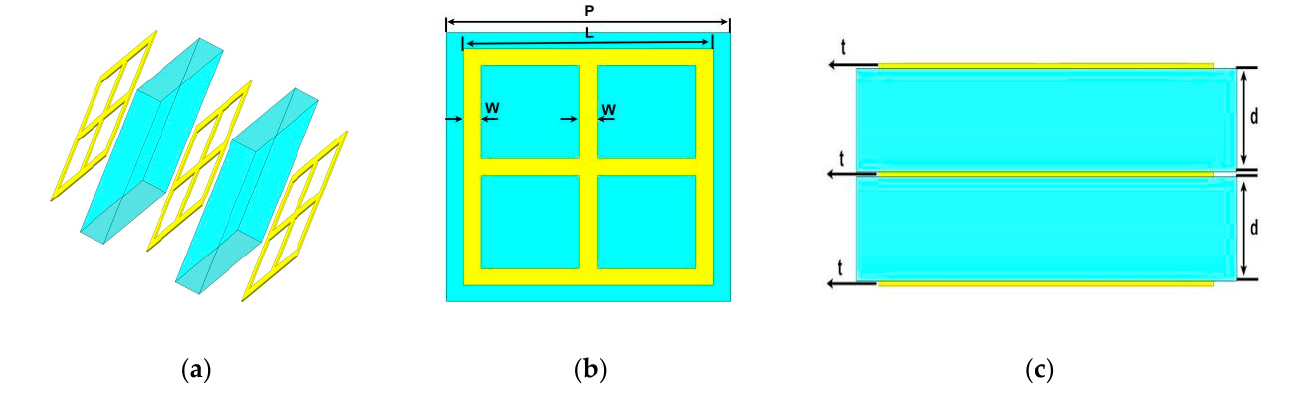
Figure 1. Structure of THz filter: ( a ) Layered structurer; ( b ) Top view; ( c ) Side view. The broadband filter designed in this paper is computer simulated and optimized using the frequency domain solver of CST Microwave Studio. In order to simulate an infinitely periodic cell, periodic boundary conditions are selected along the x-y plane during the simulation, while open boundary conditions are selected along the z plane during the simulation. In addition, the electric (E) and magnetic (H) fields are parallel to the incident plane, while the propagating wave vector (k) is perpendicular to the structure plane. To explore the filtering performance of this filter, the transmission coefficient of the normal incident wave is focused on. The transmission curves are obtained by simulation as shown in Figure 2. The simulation results show that the center frequency of the filter is 1.08 THz, the − 20 dB bandwidth can reach 1.07 THz, and the average transmission rate